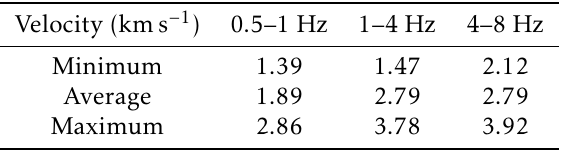
Figure 3: Absolute values of lag times against intersta- tion distances. The slope is equivalent to 1 { v . The 5 th and 95th percentiles stand for maximum and minimum velocity trends,